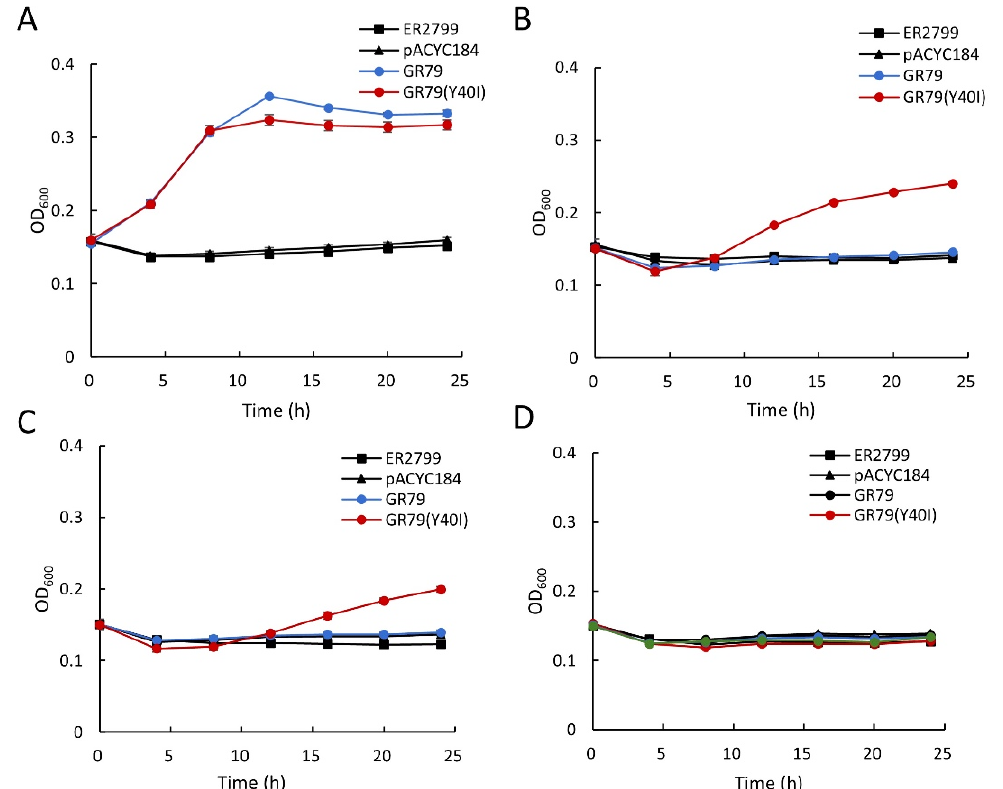
Figure 1. The growth curves of E. coli harboring pACYC184, pAGR79 and pAGR79(Y40I) plasmids under different concentrations of glyphosate. ( A ) 0 mM glyphosate; ( B ) 200 mM glyphosate; ( C ) 300 mM glyphosate; and ( D ) 400 mM glyphosate. Data are expressed as the average ± S.E. of three independent experiments.